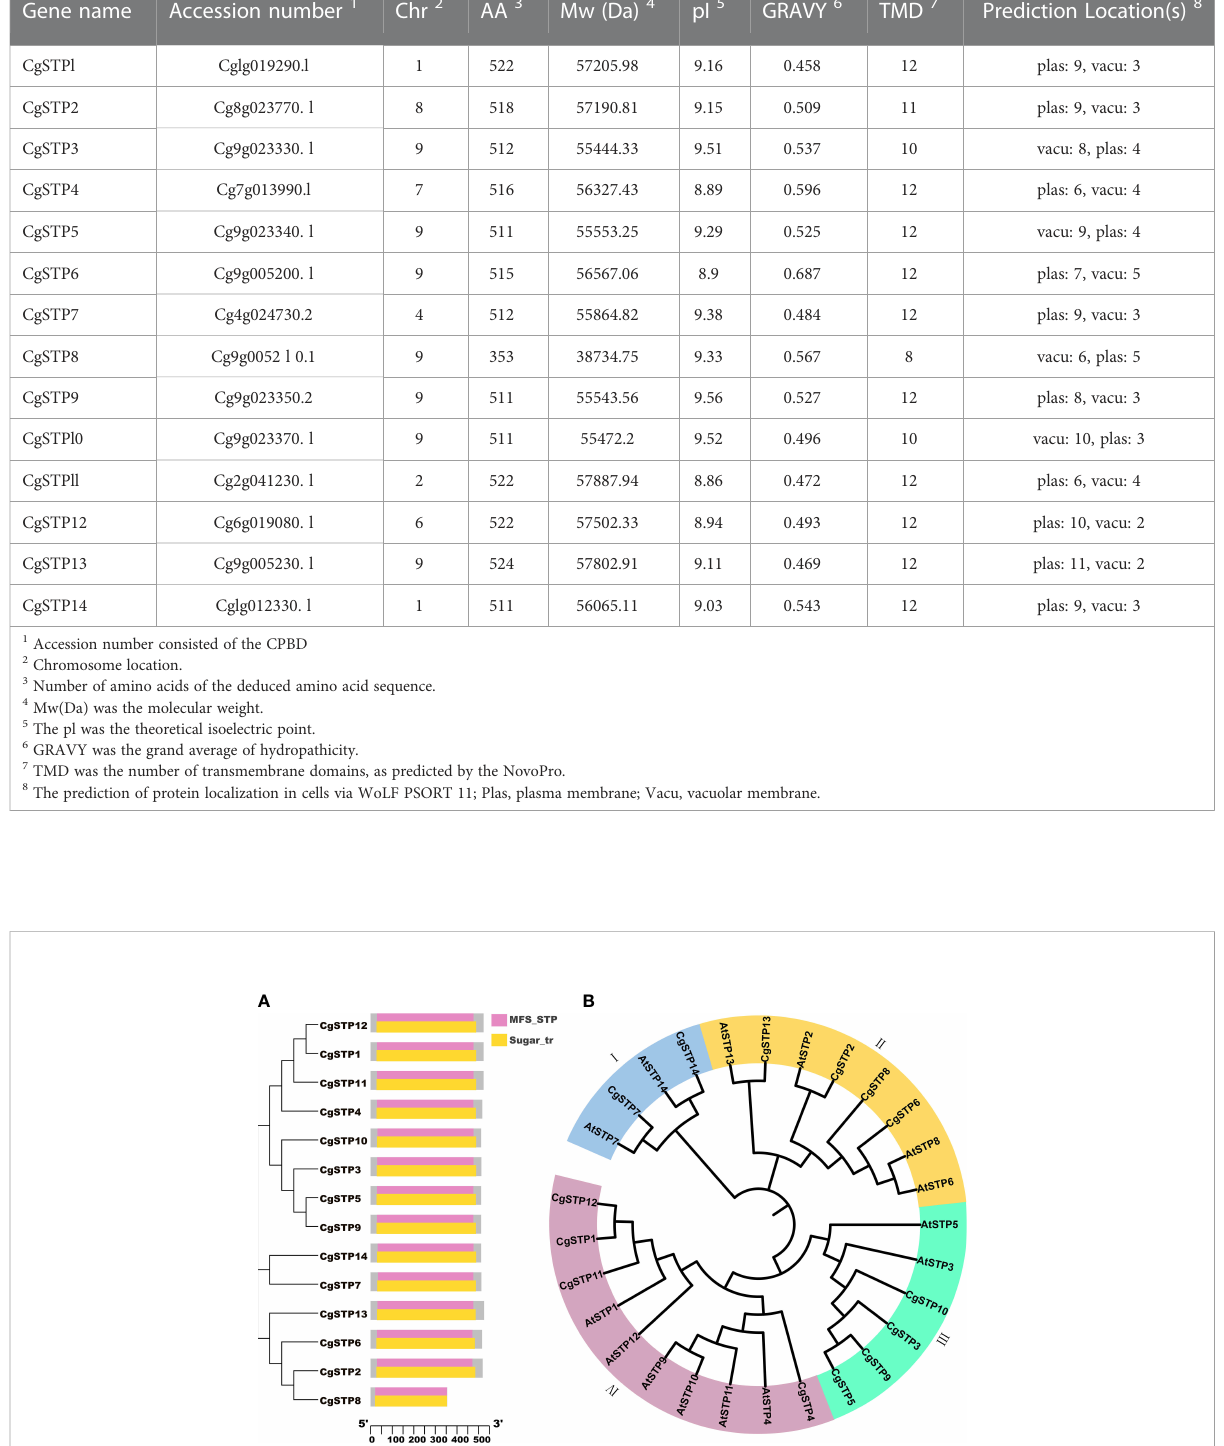
FIGURE 1 Phylogenetic analysis of STP members from C grandis and A thaliana , and conserved domain analysis of CgSTPs. (A) The conserved domain analysis was performed through the NCBI Batch CD-search tool. (B) A total of 14 STP protein sequences from C grandis and 14 STP protein sequences from A thaliana were aligned by ClustalW method. The MEGAX program was applied to construct the phylogenetic tree by the ML method in the default parameters. The beauti fi cation of the tree was carried out on the iTOL